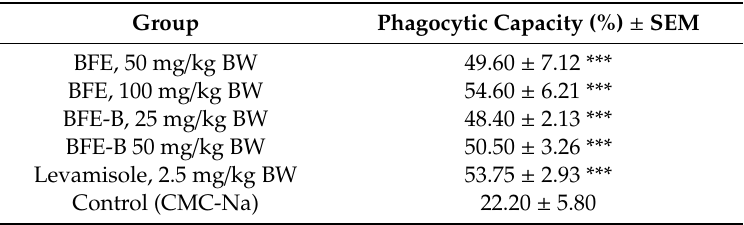
Table 2. Effect of water-soluble fibers of P. erosus (BFE and BFE-B) on nitric oxide production in the peritoneal macrophages of mice induced by hepatitis B vaccine.